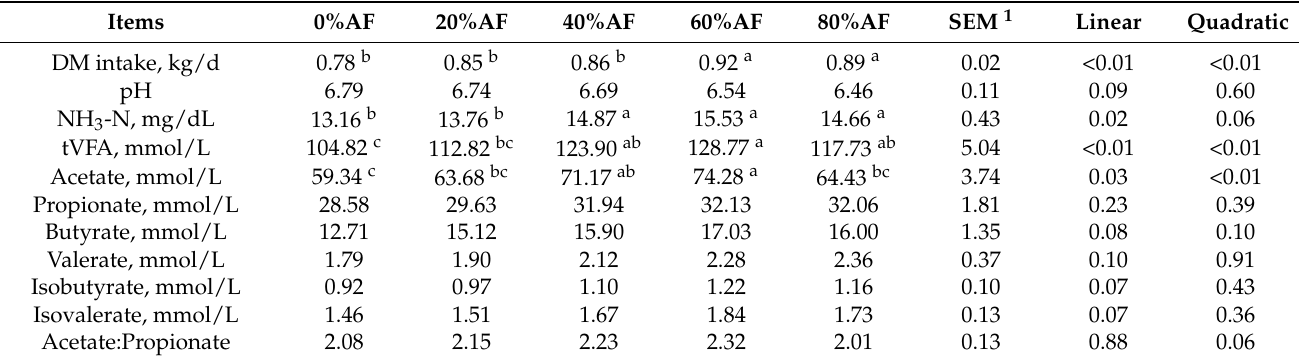
Table 3. The effects of alfalfa–sweet sorghum (AF–SS) silage-based diets on DM intake and physio- logical status in rumen of Karakul